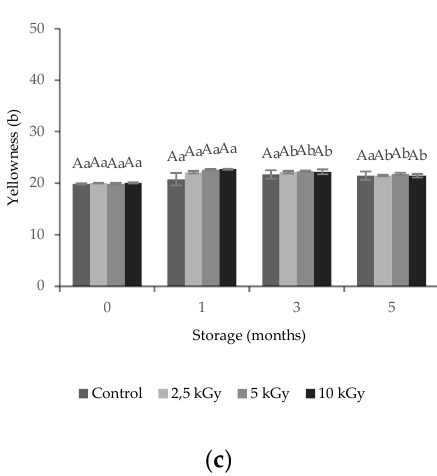
Figure 2. The color changes during the storage of irradiated and control tarhana samples. ( a ) Lightness L, ( b ) redness + a, ( c ) yellowness + b. Capital letters represent the p < 0.05 level of statistical difference between the storage times of the tarhana samples, while the lower-case letters show the p < 0.05 level of statistical difference between the irradiation doses.